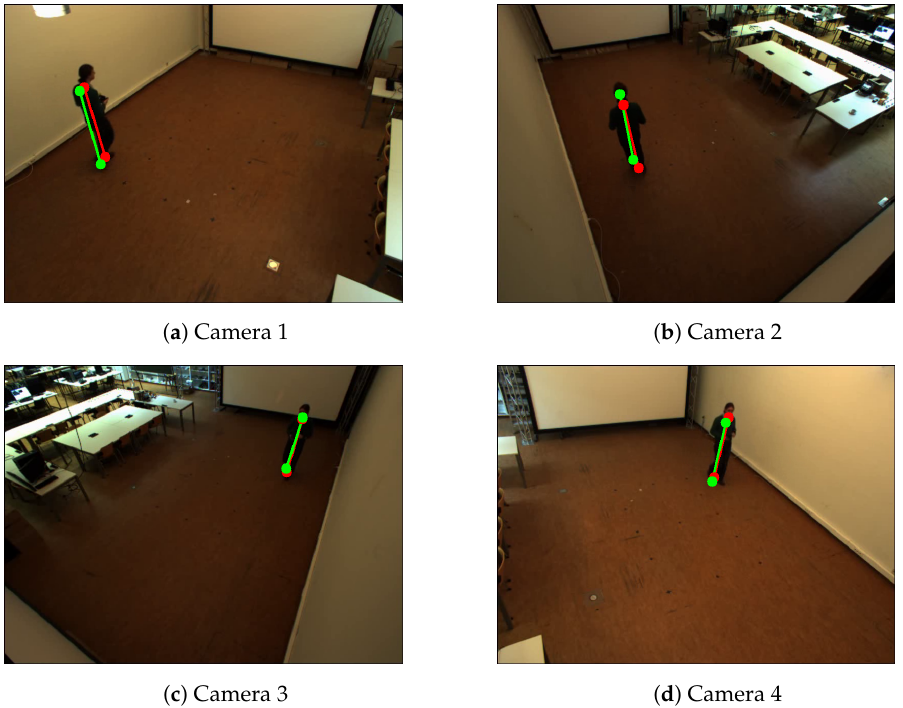
Figure 3. Example of detected the bottom and top positions of the pedestrians of Camera Network 1—single person walking in an empty room. Red color represents detected positions by the human pose estimation method. Green color represents the detected reprojected positions.